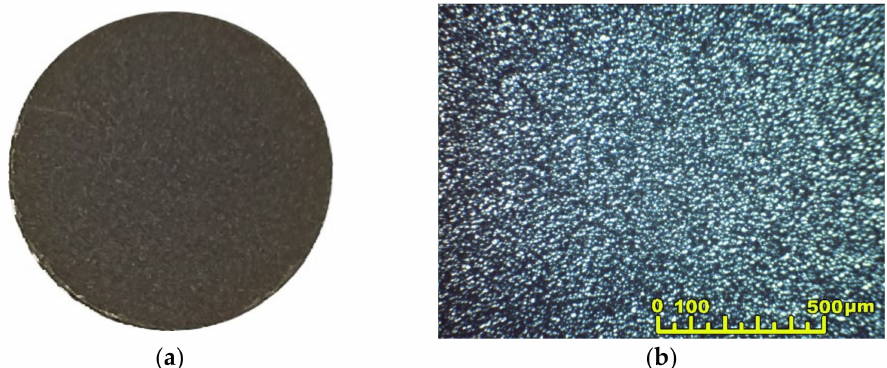
Figure 8. Optical images of the surface of the BCSCuO coating on the dense SDC substrate after deposition using the PPy conductive sublayer followed by drying for 24 h and sintering at 1530 ◦ C for 5 h: ( a ) photograph of the sample; ( b ) optical